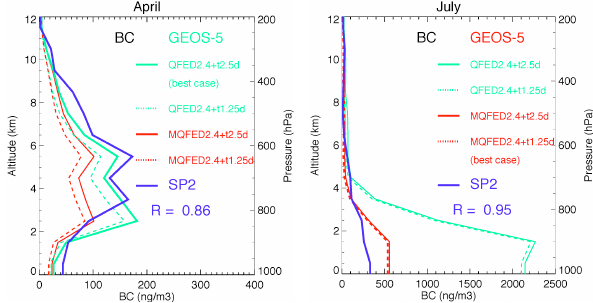
Figure 3. Vertical distribution of BC mass concentration (ng/m 3 ) from DC-­‐8 measurement and GEOS-­‐5 simulations when the GEOS-­‐5 model results are sampled by all flights for April (Fig. 2a) and July (Fig. 2b). Four model sensitivity experiments were conducted to test the different biomass burning emissions (green line for QFED 2.4 and red line for Modified QFED 2.4) and BC aging e-folding timescales (solid line for e-folding time 2.5 days and dash line for 1.25 days). The thick lines (i.e., green solid line in April and red dashed line in July) are the “best” simulations used in the discus- sion of source attribution. Correlations between the measurement and the best model simulation are